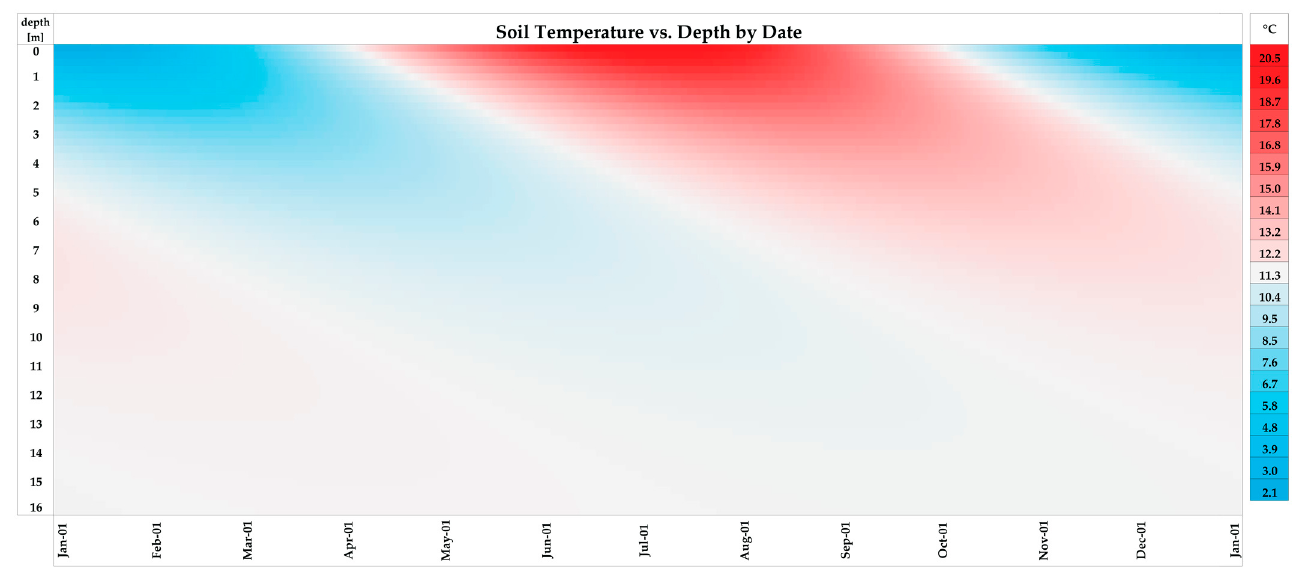
Figure 2. Generalized soil temperature with depth and date with no surface coverage at the test site.